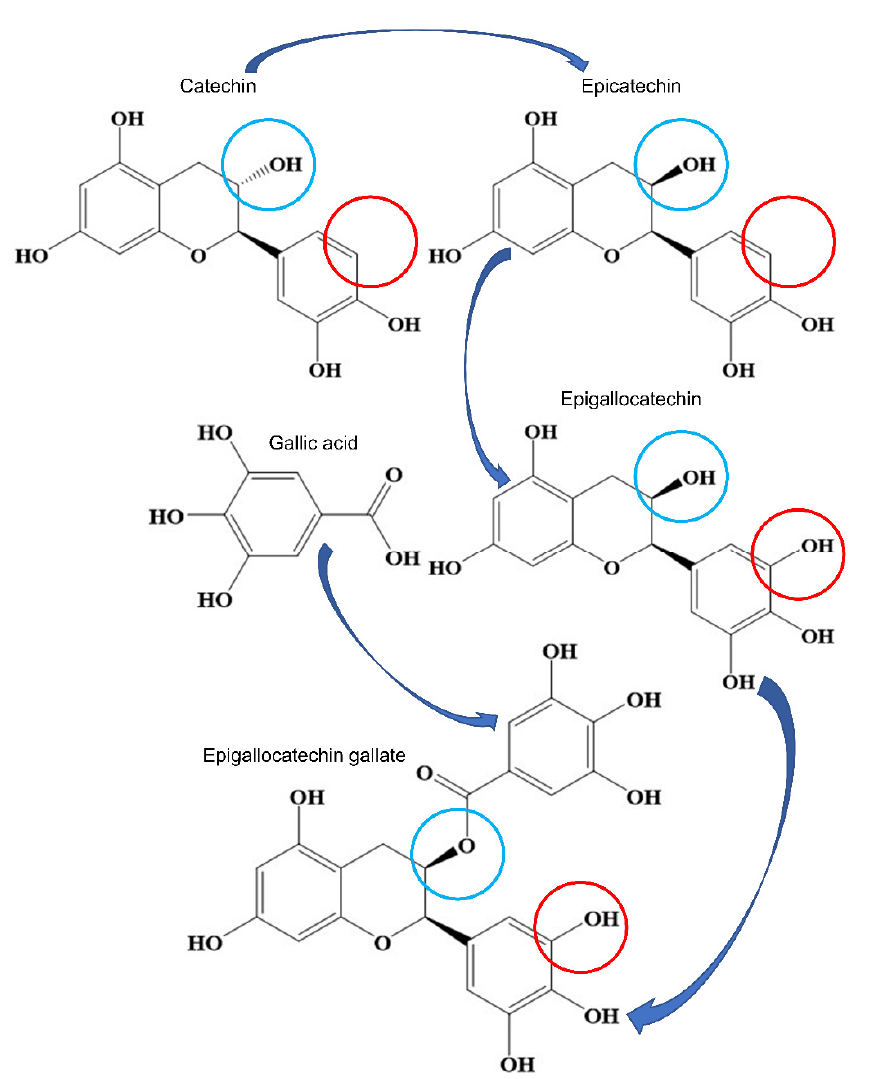
Figure 1. The relationship of epigallocatechin gallate (EGCG) and its derivates catechin, epicatechin, epigallocatechin, and gallic acid. It indicates that EGCG is the ester of epigallocatechin and gallic acid. The blue and red circles highlight the main structural differences of these compounds.